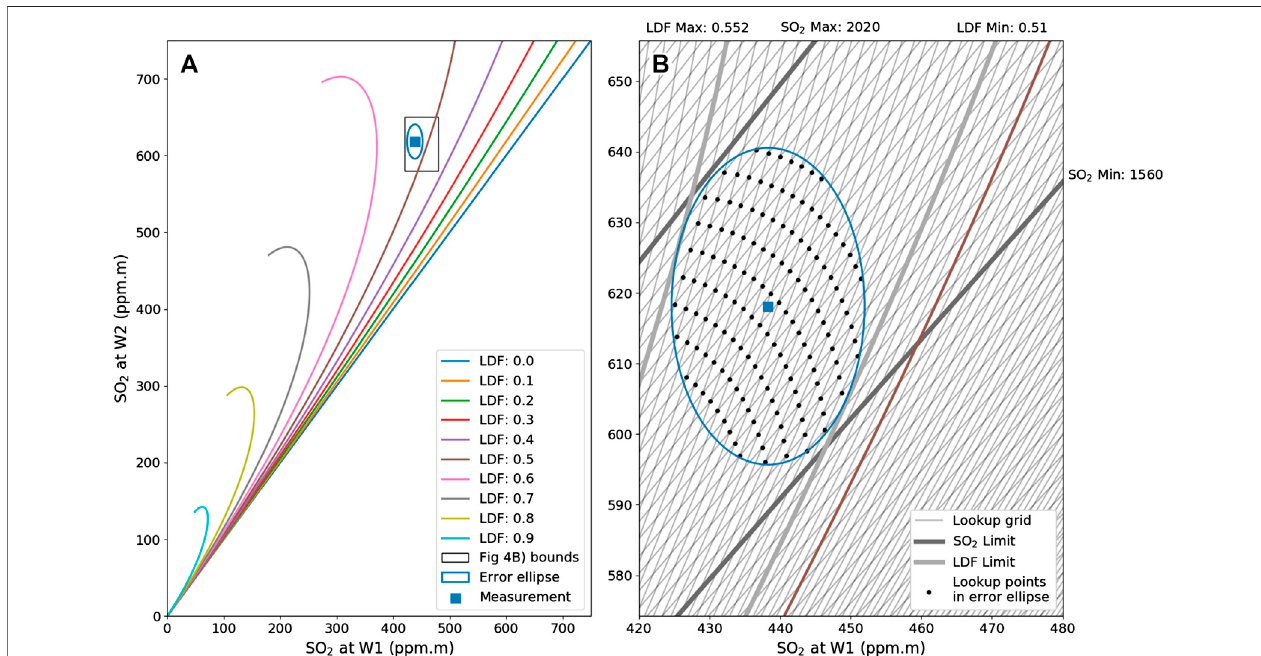
FIGURE4|(A) AsinglemeasurementofSO 2 (bluesquare)atW1(306 – 316 nm)and W2(312 – 322 nm)isshown withatypical fi ttingerror(blueellipse).Itisplotted onasetoflightdilutioncurvesspacedwithLDFsbetween0and0.9.Theblackboxhighlightstheregionofthegraphfor (B) . (B) Showsthefulllightdilutionlookuptable. Here, the SO 2 grid is spaced every 20 ppm m between 0 and 5,000 ppm m, and LDF is spaced every 0.02 between 0 and 0.998. The intersections of the grid that lie in the error ellipse are plotted. An estimate of the SO 2 is made from interpolating the measurement point inside the grid, giving a best estimate of LDF and SO 2 . An estimate for the error is provided by fi nding the fi rst line that does not contain a lookup point inside the error